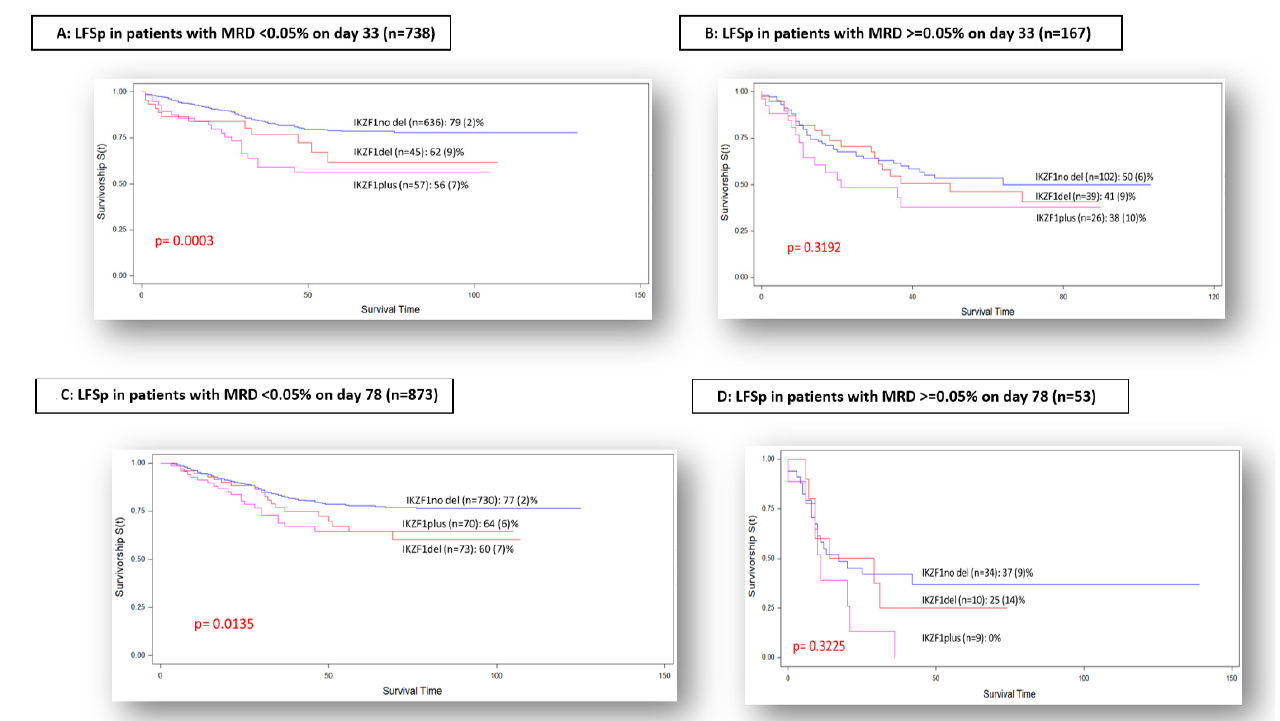
Figure 2. LFS probability according to MRD on day 33 and on day